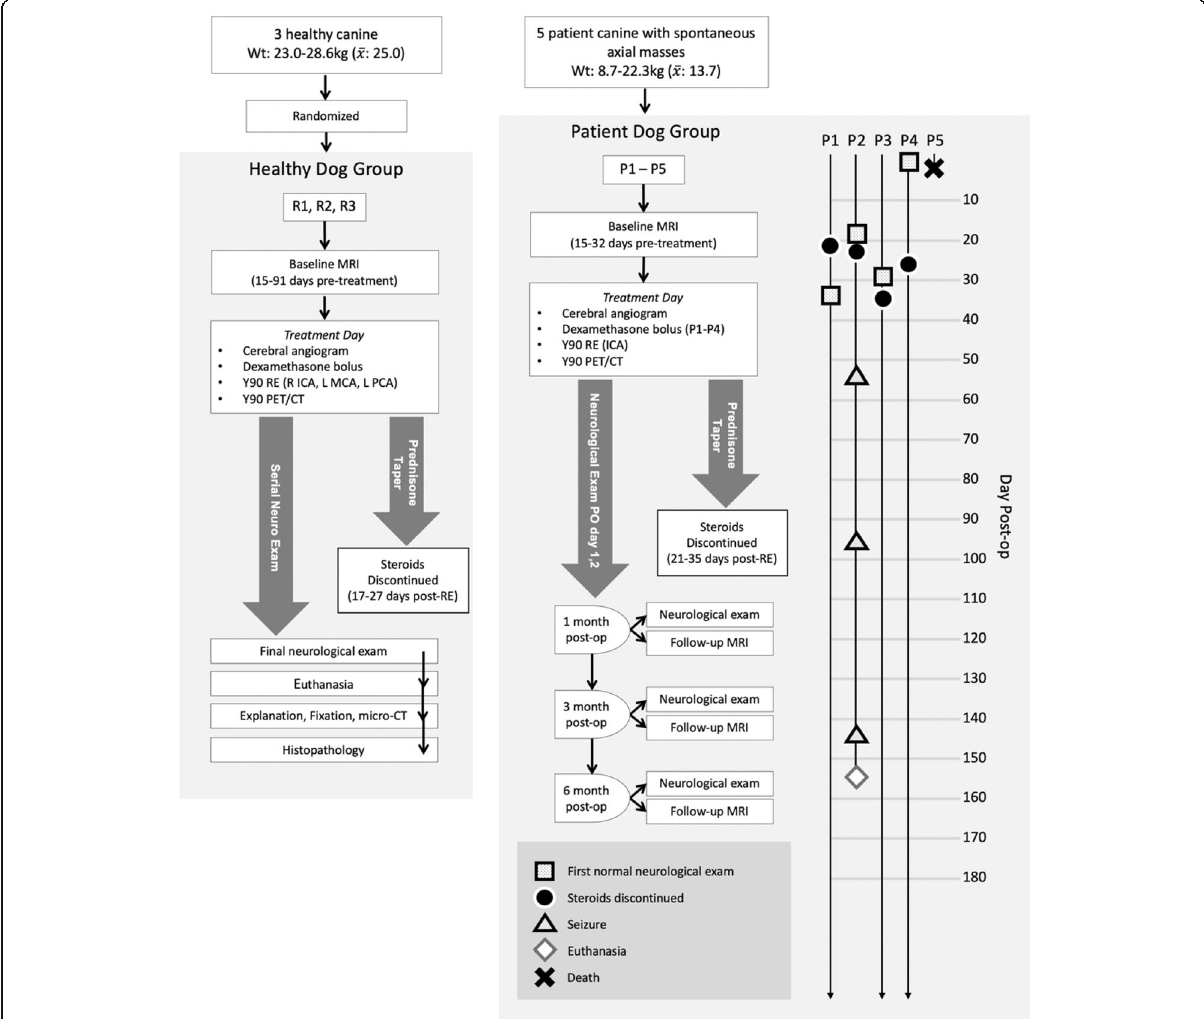
Fig. 1 Flowchart of the clinical protocol used for cerebral 90 Y-RE in research and patient dogs. An event plot is shown for patient animals as a function of days post- 90 Y-RE. All animals experienced generalized seizure activity prior to therapy (Table 1, Supplemental